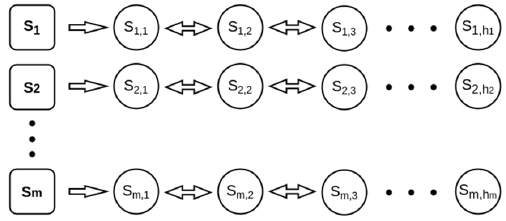
Fig. 2. Representation of a